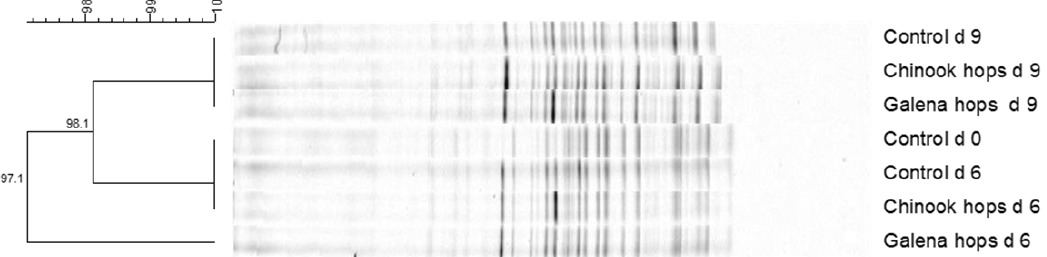
Figure 3. Denaturing gradient gel electrophoresis dendrogram from Experiment 1 showing effects of 0.26% ( wt / wt ) Chinook or 0.09% ( wt / wt ) Galena hops treatment on microbial diversity of composting poultry litter. Percentage similarity coefficient (the bar) between bands is considered likely the same or identical if ≥95, very similar if between 90 to 94, considered similar if between 85 to 89, and considered somewhat similar if between 80 to 84. It is not considered similar if ≤79. Table 1. Analysis of variance results for effects of hops treatments, day of compost and their interac- tions on nitrogen and select microbiological populations after nine days of simulated composting of wood chip poultry litter mixed (Experiment 1) 1